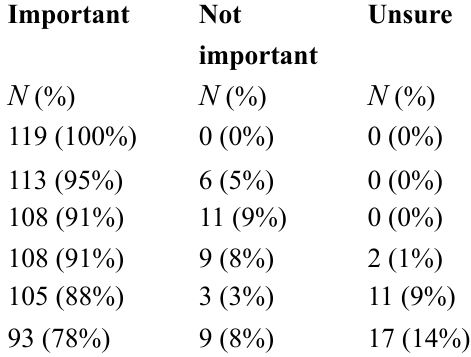
Table 2 : The relative importance of factors that may influence optometry students to consider community service ( N Salary and personal safety were considered the most important